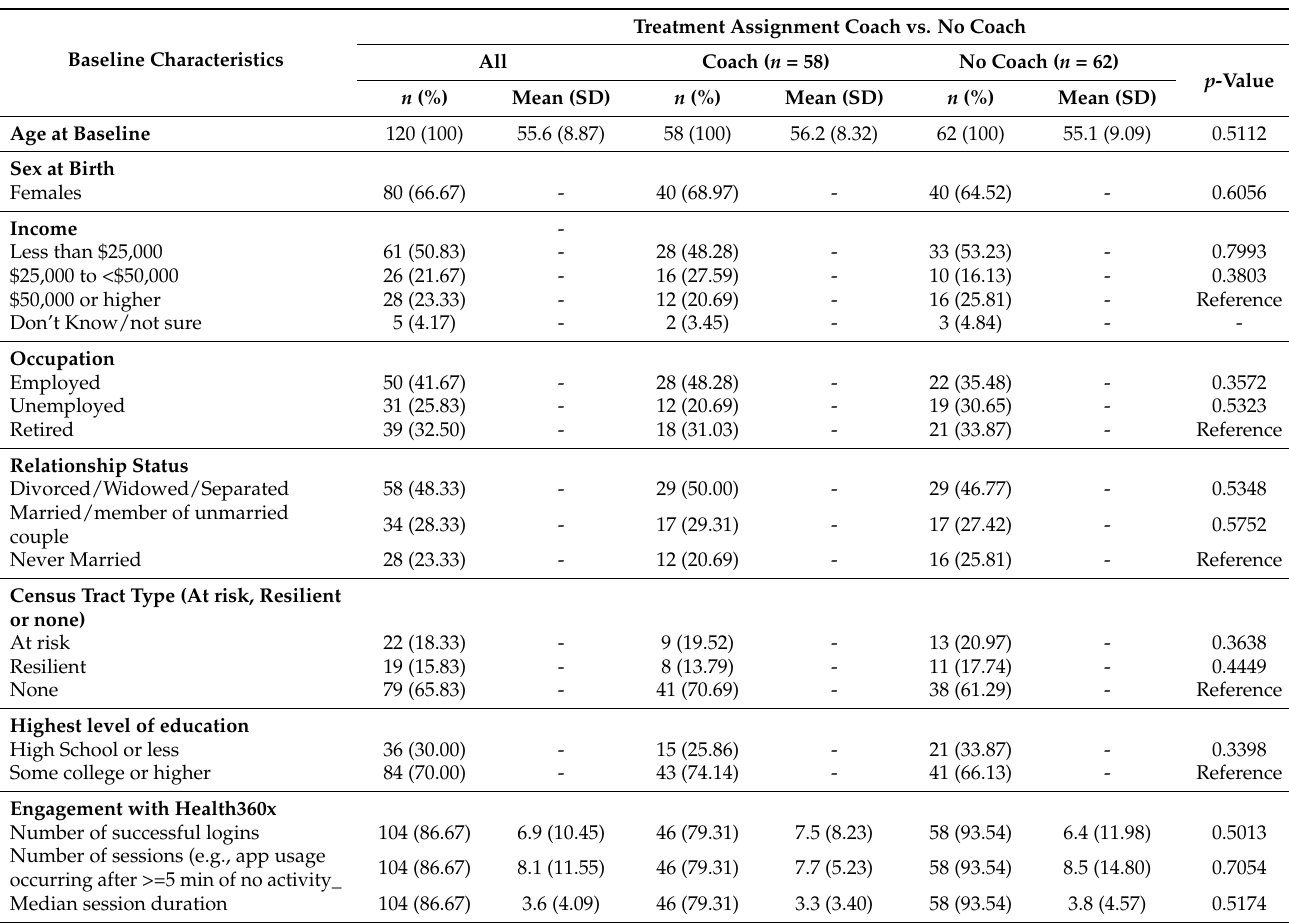
Table 1. Participants’